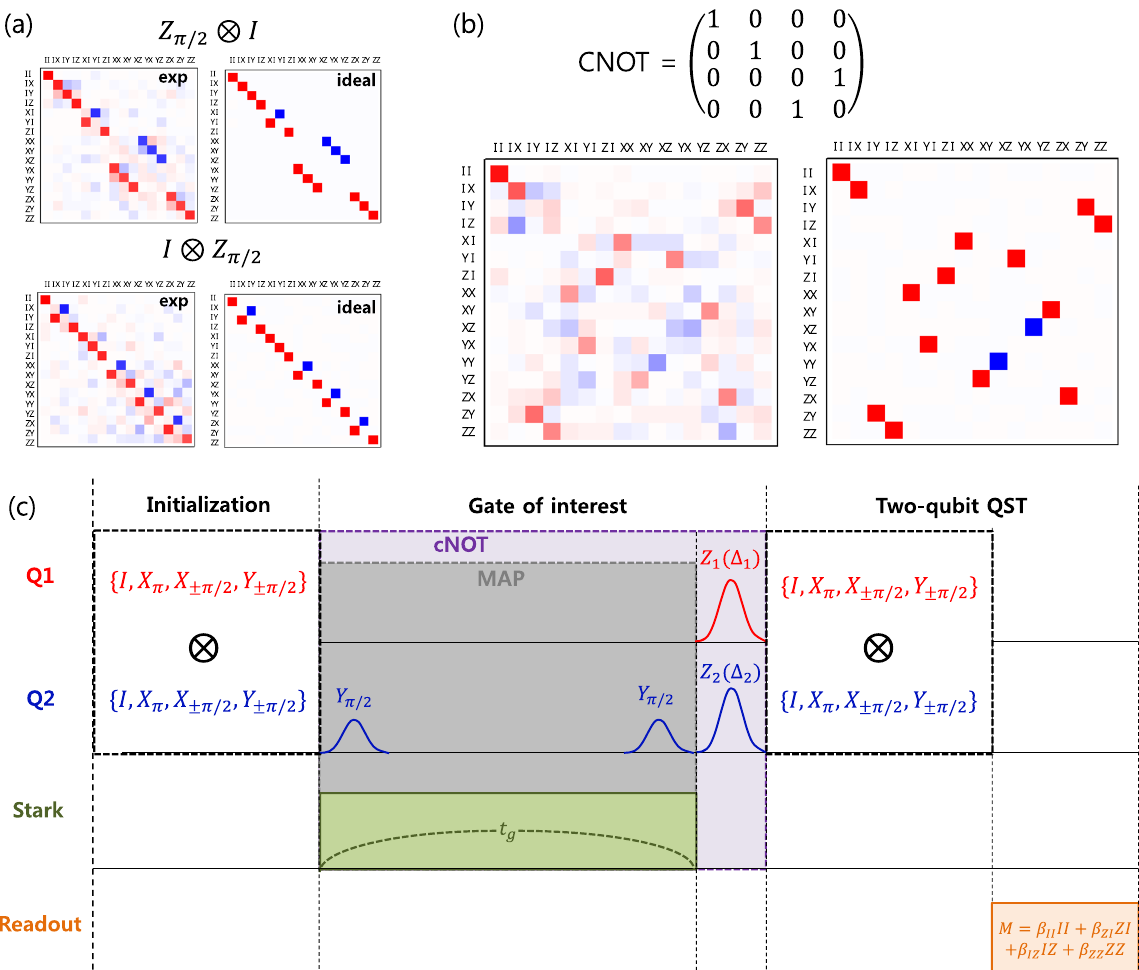
Figure 4. ( a ) Pauli transfer matrix R of the single-qubit gate ⊗ π Z I gate, ideal R is represented along with the experimental R for comparison. ( b ) Pauli transfer matrix R of the cNOT gate reconstructed from experimental data (left) along with the ideal matrix (right). ( c ) Schematic diagram of the pulse sequence for two-qubit QPT in case of the cNOT